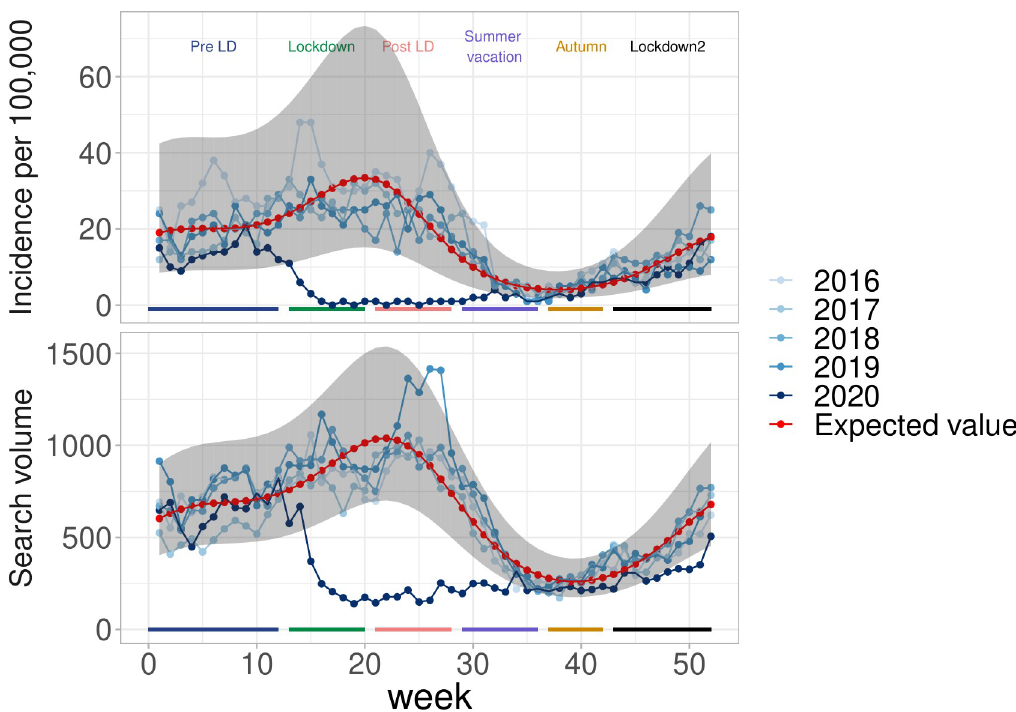
Fig 2. Chickenpox in France during the COVID-19 pandemic. (top) Incidence in general practice and (bottom) search query volume.